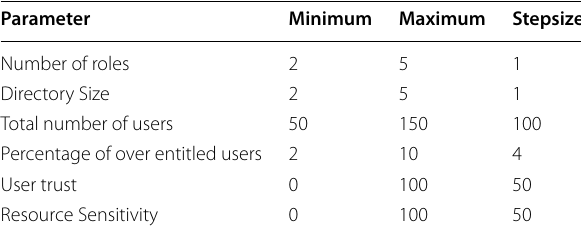
Table 1 Experimental analysis parameter variation (minimum, maximum and